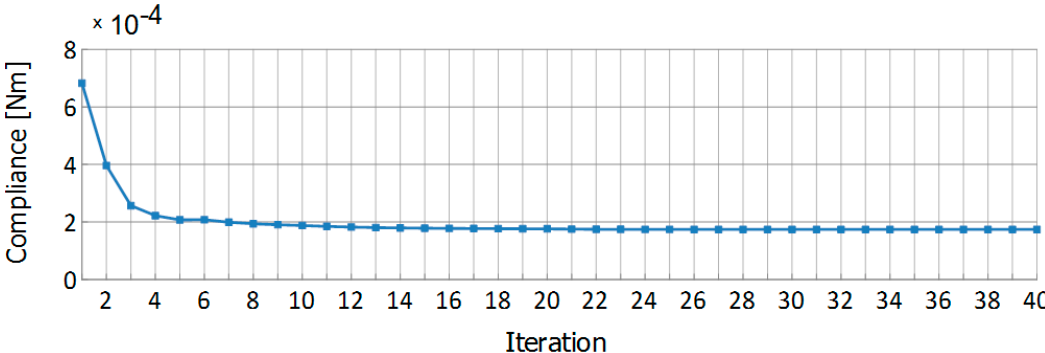
Figure 24. The iteration history for the T-bracket example.